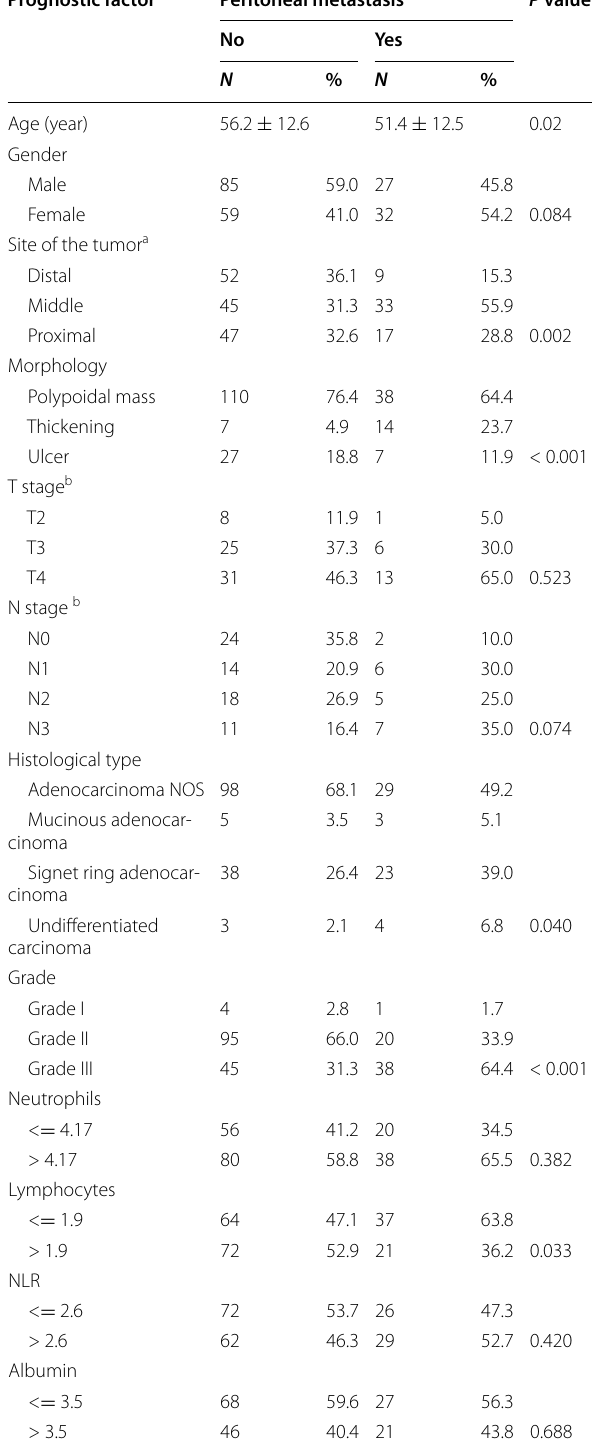
Table 1 Association between different demographic, pathological and laboratory markers with presence of peritoneal metastases Prognostic factor